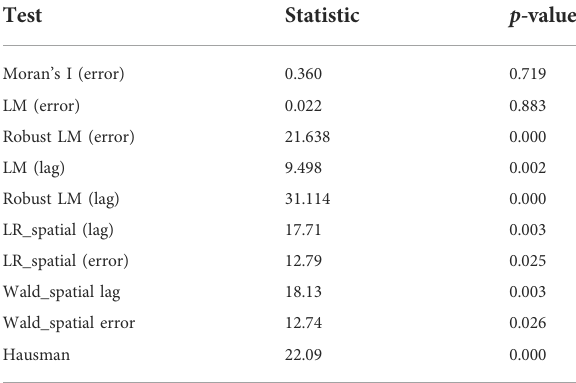
TABLE 3 Results of spatial econometric model correlation tests.